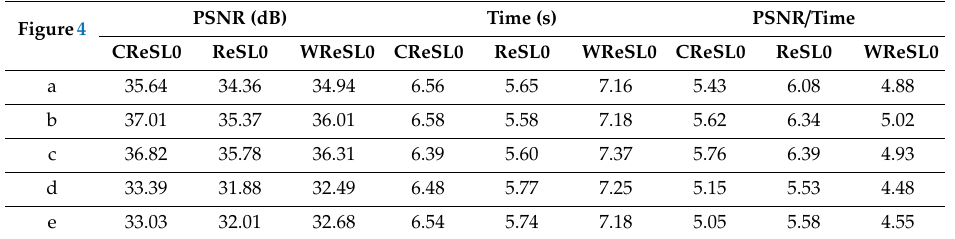
Table 1. The PSNR, time and PSNR / time of each algorithm for five images. ReSL0: regularized smooth L0; CReSL0: combined regularized smooth L0; WReSL0: weighted regularized smooth L0.